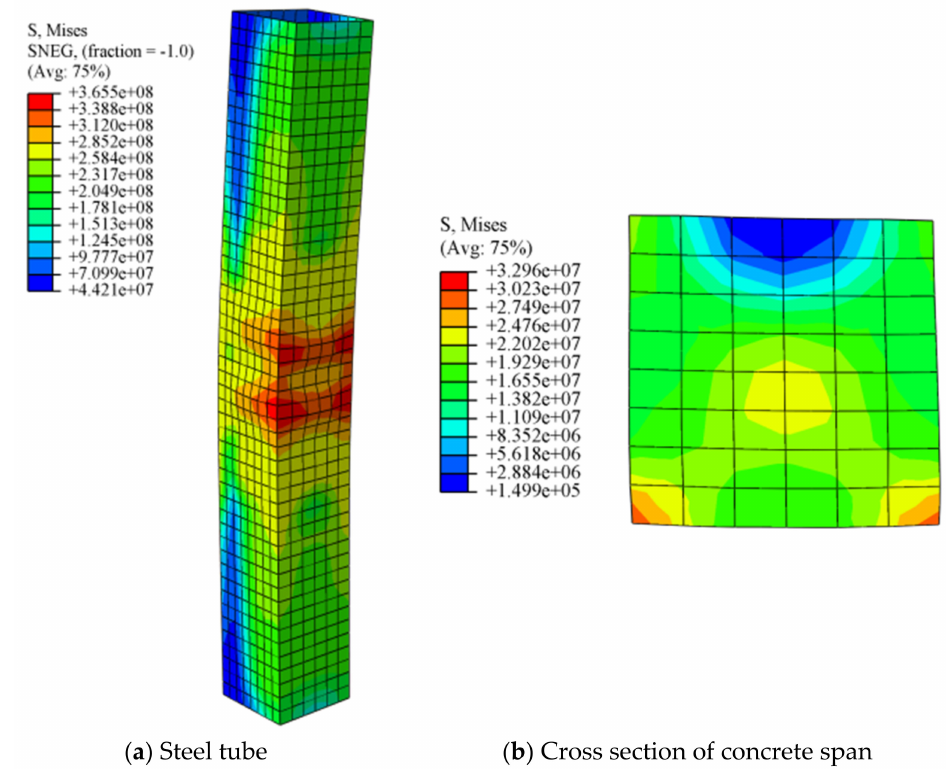
Figure 5. Stress cloud diagram ( a ) steel tube ( b )